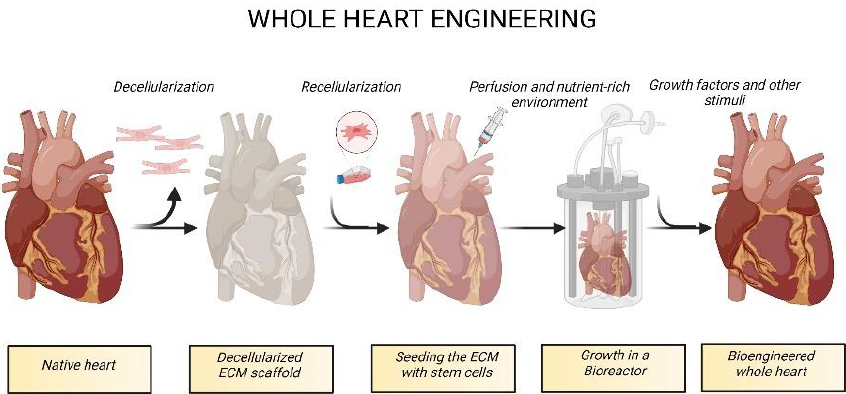
Figure 1. Growing heart in a bioreactor. Building a heart starts with the decellularization of the organ, which creates an acellular scaffold consisting of structural proteins such as collagen and laminins, as well as proteoglycans and polysaccharides. This scaffold is further seeded with cells and cultured in a bioreactor to mimic the natural heart functions. A bioreactor supports and protects the engineered construct, providing nutrients and a sterile environment. This technique would create a functional bioartificial heart, a theoretical alternative to transplantation. Created with BioRen- der.com.